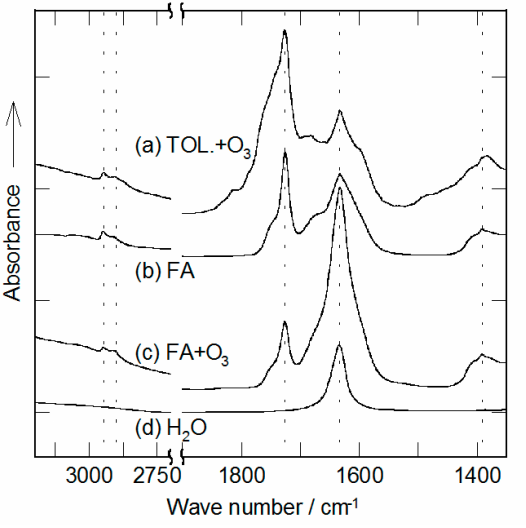
Figure 8. Infra-red spectra of ( a ) toluene adsorbed onto H-Y(1) after introducing O 3 , ( b ) formic acid adsorbed onto H-Y, ( c ) after adducting O 3 , and ( d ) H 2 O adsorbed onto